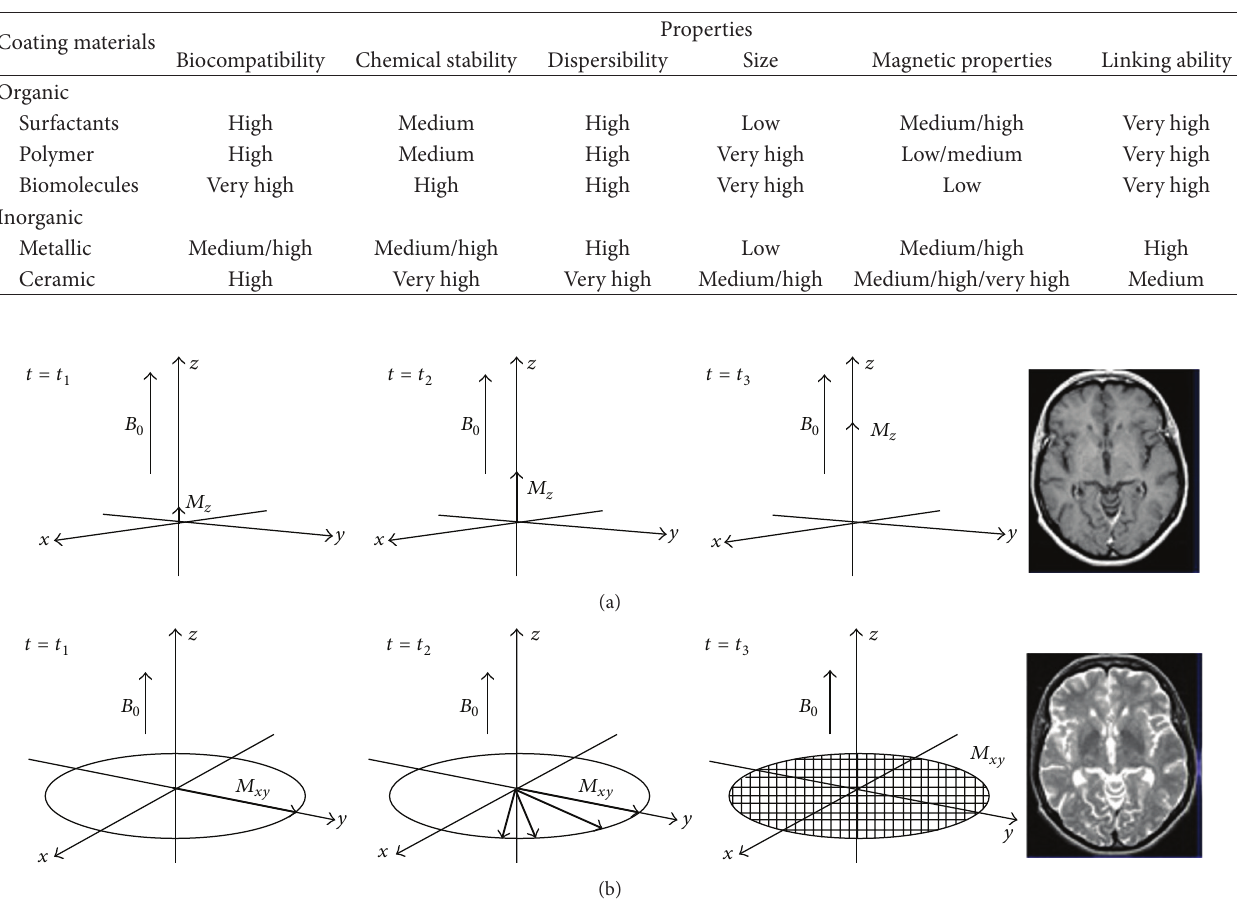
Figure 17: The schematic of 𝑇 1 and 𝑇 2 relaxations mechanisms. (a) The schematic of 𝑇 1 recovery mechanism and (b) the schematic of 𝑇 2 decay mechanism